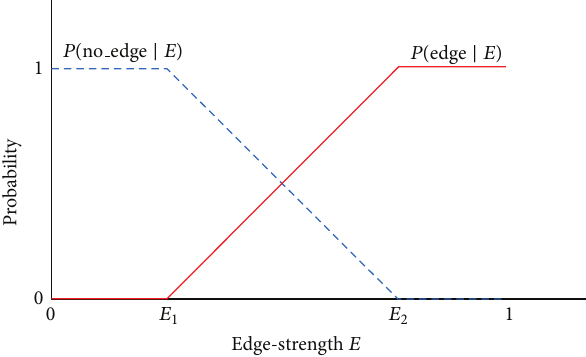
Figure 3: Trapezoidal functions representing the conditional prob- abilities for a pixel to be “edge” or “not edge,” given edge-strength 𝐸 of the pixel.